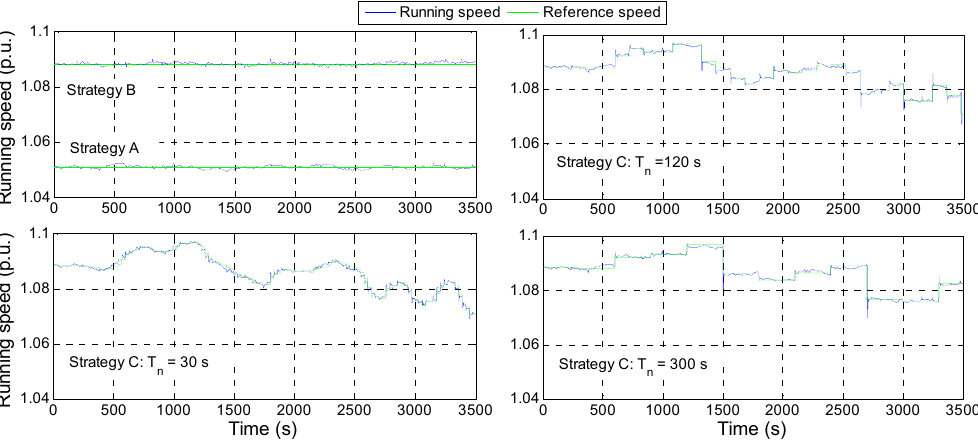
Figure 8. Running speed and reference speed with the three strategies. Long penstock configuration, p 0 = 0.7 p.u., h c0 = 1.131 p.u., scenario 1.